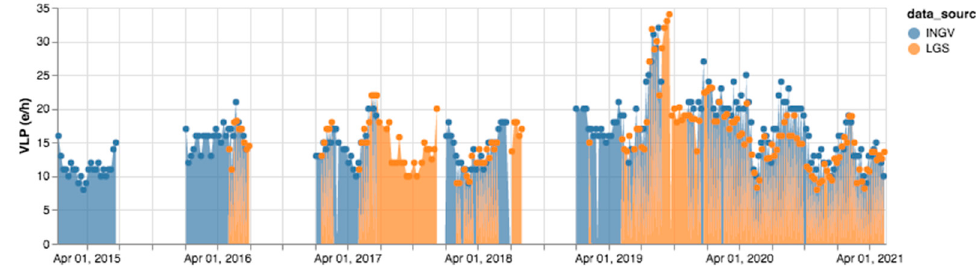
Figure 12. Comparison of VLP events recorded in INGV and LGS bulletins in 2015–2021.